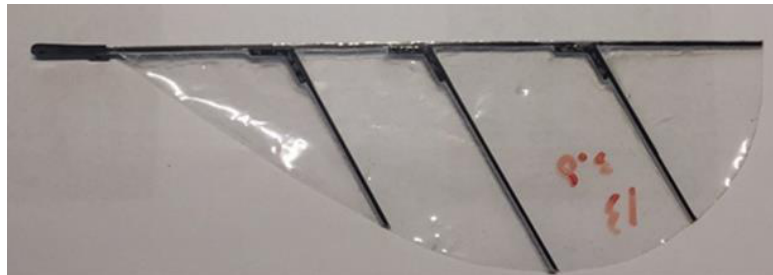
Figure 4. The rigid wing of the FWR without torsion.